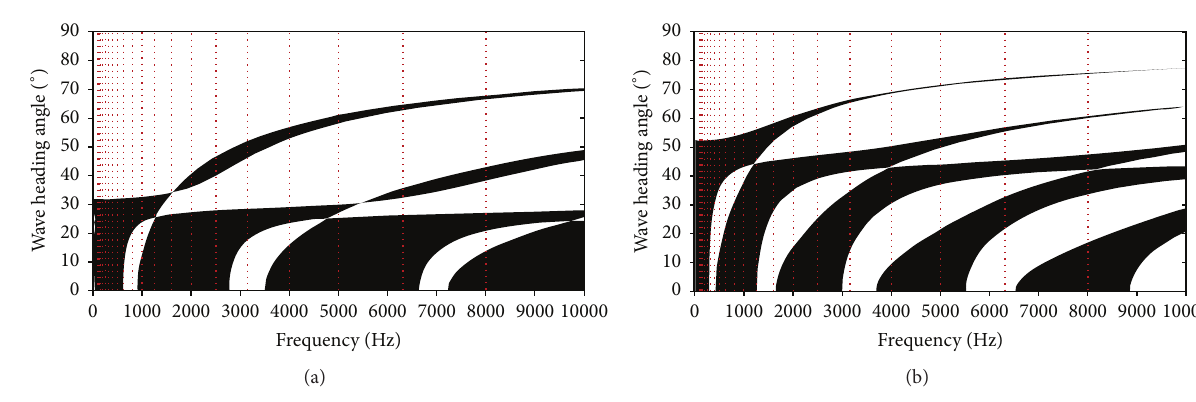
Figure 3: Propagation zones (black areas) and attenuation zones (white areas) for the periodic ribbed plate at different wave heading angles. (a) L-junctions A and B: Plate 2; (b) L-junction B: Plate 1. The red dotted lines indicate the one-third octave band centre